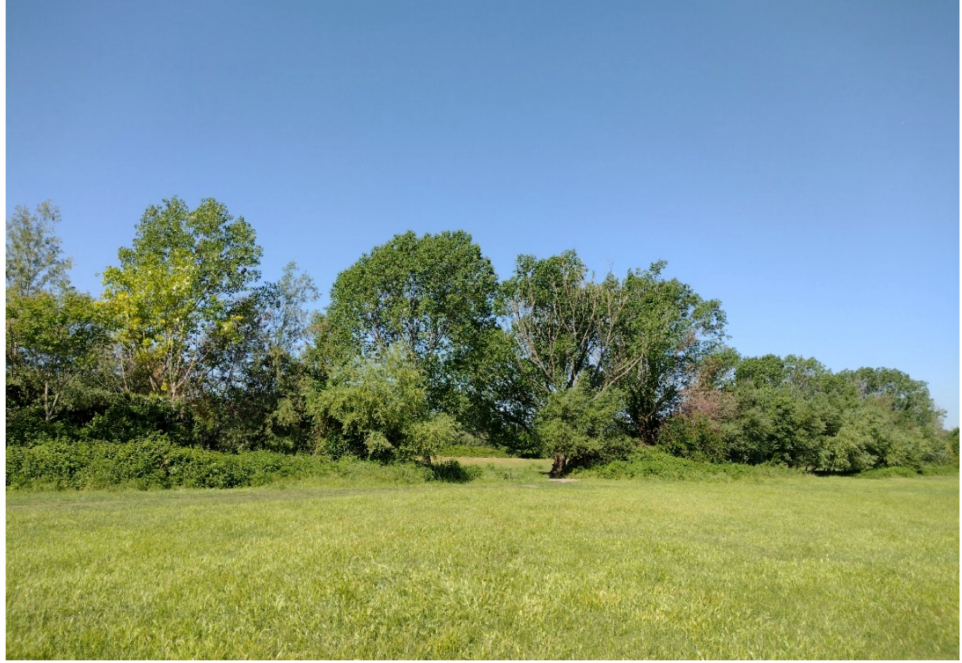
Figure 13. Landscape elements of Appia Antica Regional Park: corridors. Riparian forest in Caffarella valley.